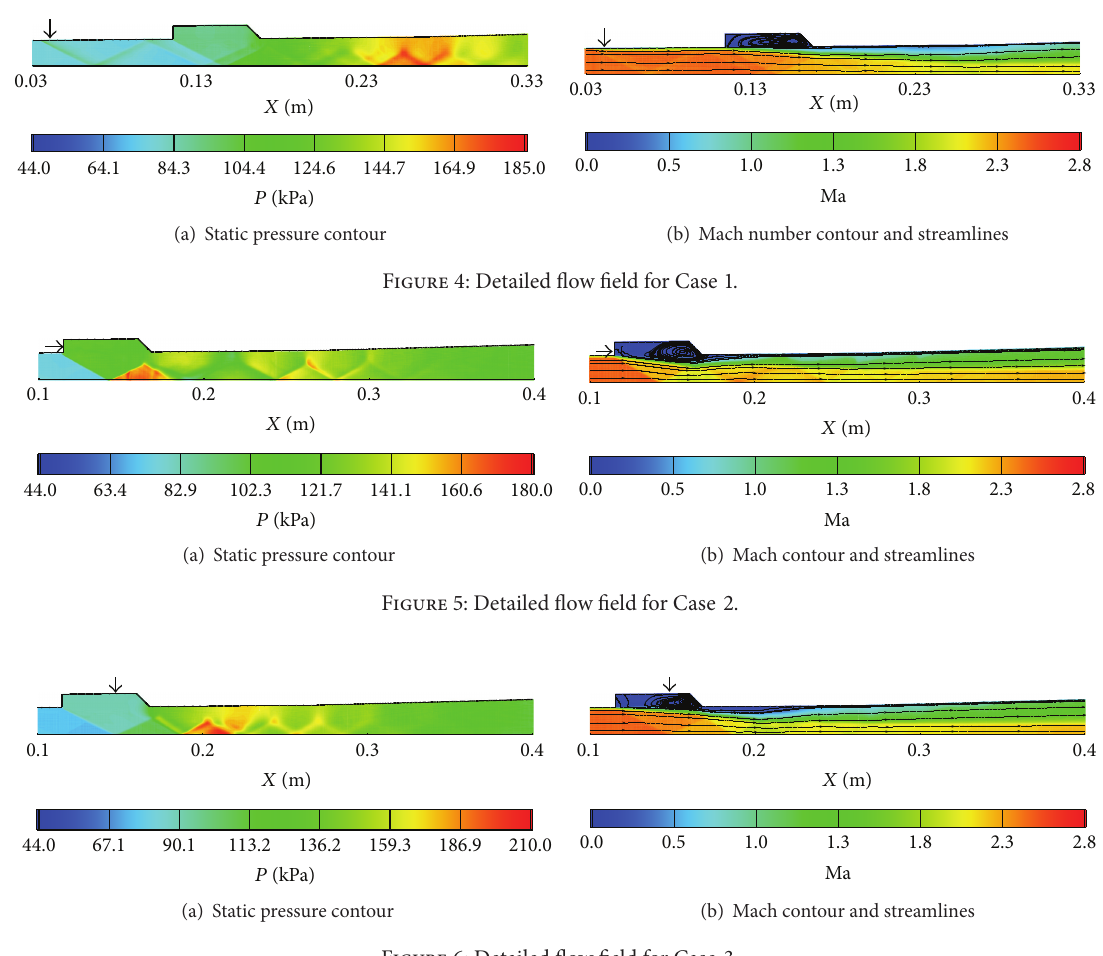
Figure 6: Detailed flow field for Case